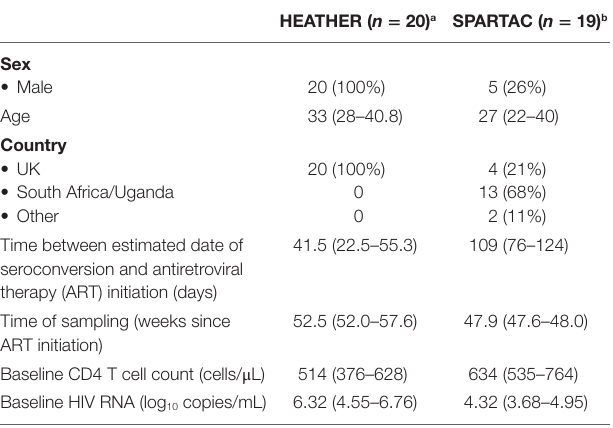
TaBle 1 | Demographic and clinical characteristics of participants included in clinical